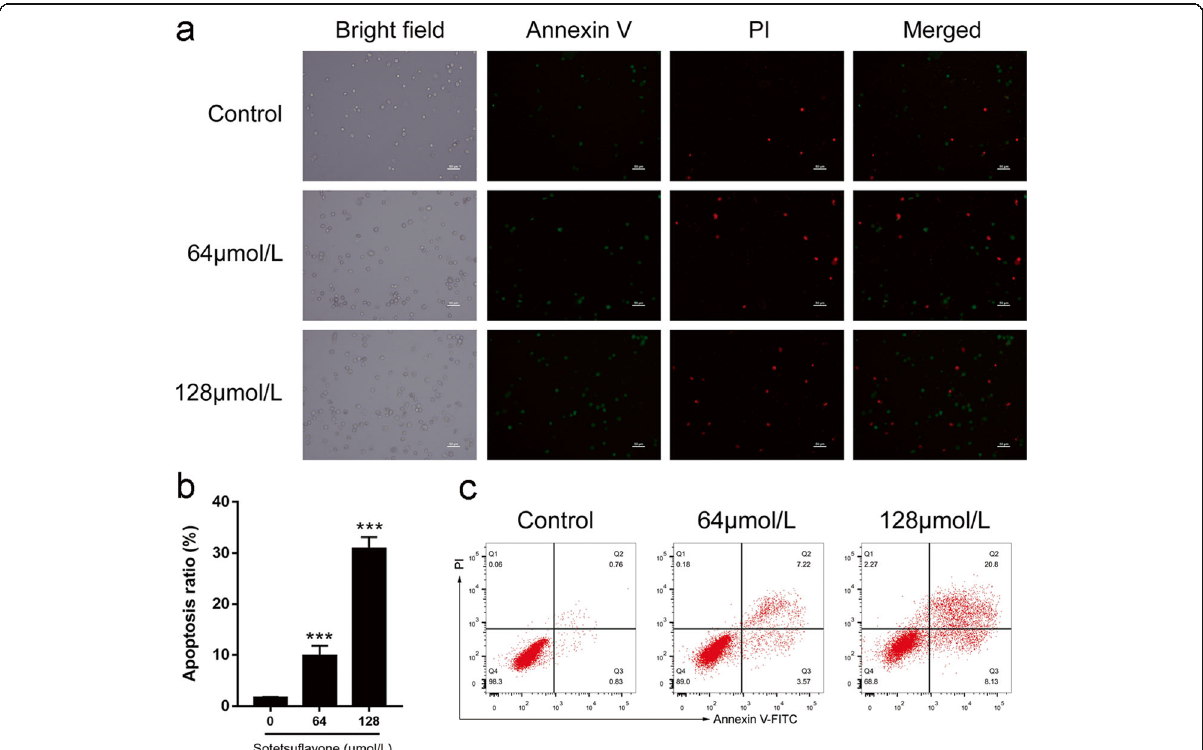
Fig. 2 Sotetsuflavone induced apoptosis in A549 cells. a Fluorescence observation after treating A549 cells with sotetsuflavone using Annexin V-FITC/ PI double staining assay (100 × magnification). b Effect of sotetsuflavone on A549 cell apoptosis rate (early and late apoptotic cells) after treating A549 cells with sotetsuflavone. c Fluorescence image analysis of apoptotic A549 cells induced with sotetsuflavone by using Annexin V-FITC/PI double staining, where quadrant Q3 are early apoptotic cells, and Q2 are late apoptotic or necrotic cells. The results from three independent experiments were expressed as mean±SD compared with the control group, *** P